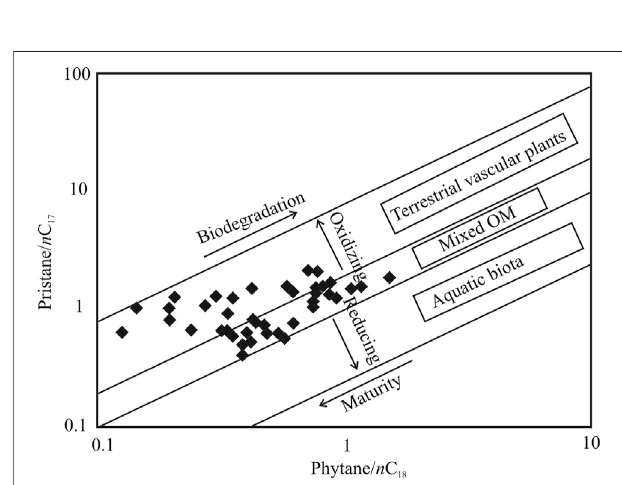
FIGURE 7 | Cross plot between pristane/ n -C 17 and phytane/ n -C 18 describing the type of biota forming the peat and organic rich layers in the studied section. The cross plot also indicates the extent of biodegradation of the preserved organic matter in the sediments, level of thermal maturity and the redox condition [modi fi ed after Alexander et al.